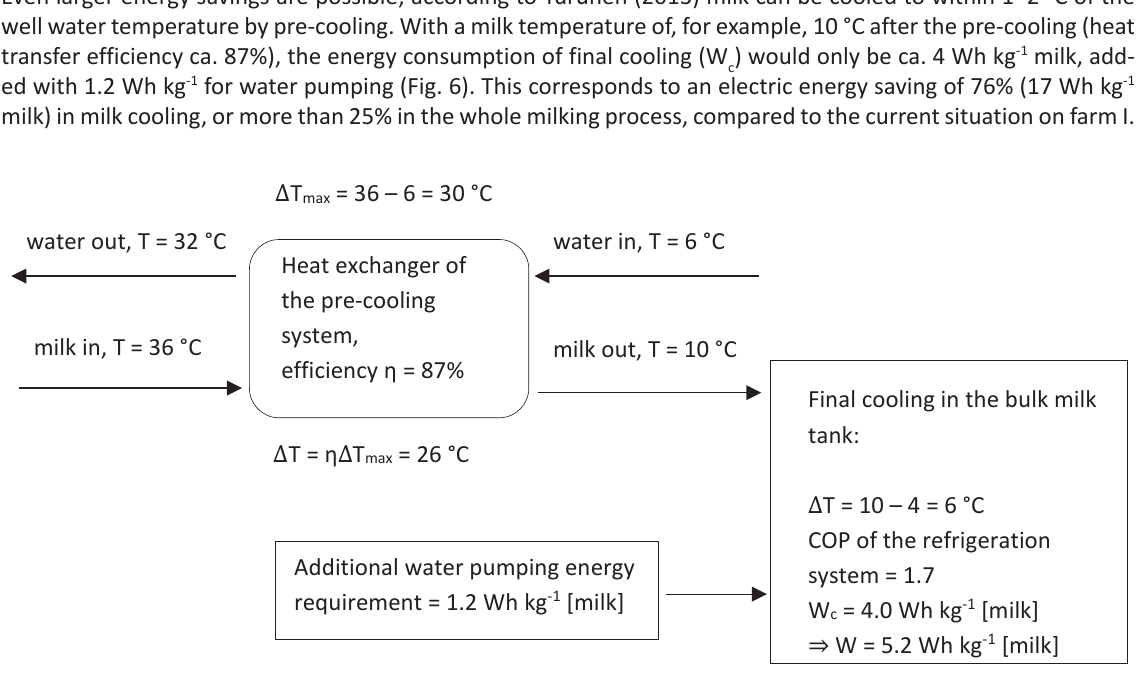
Fig. 6. Effect of milk pre-cooling system on the energy consumption of milk cooling with heat transfer efficiency of 87%. COP of the refrigeration system was assumed to be the same as the measured average value on farm